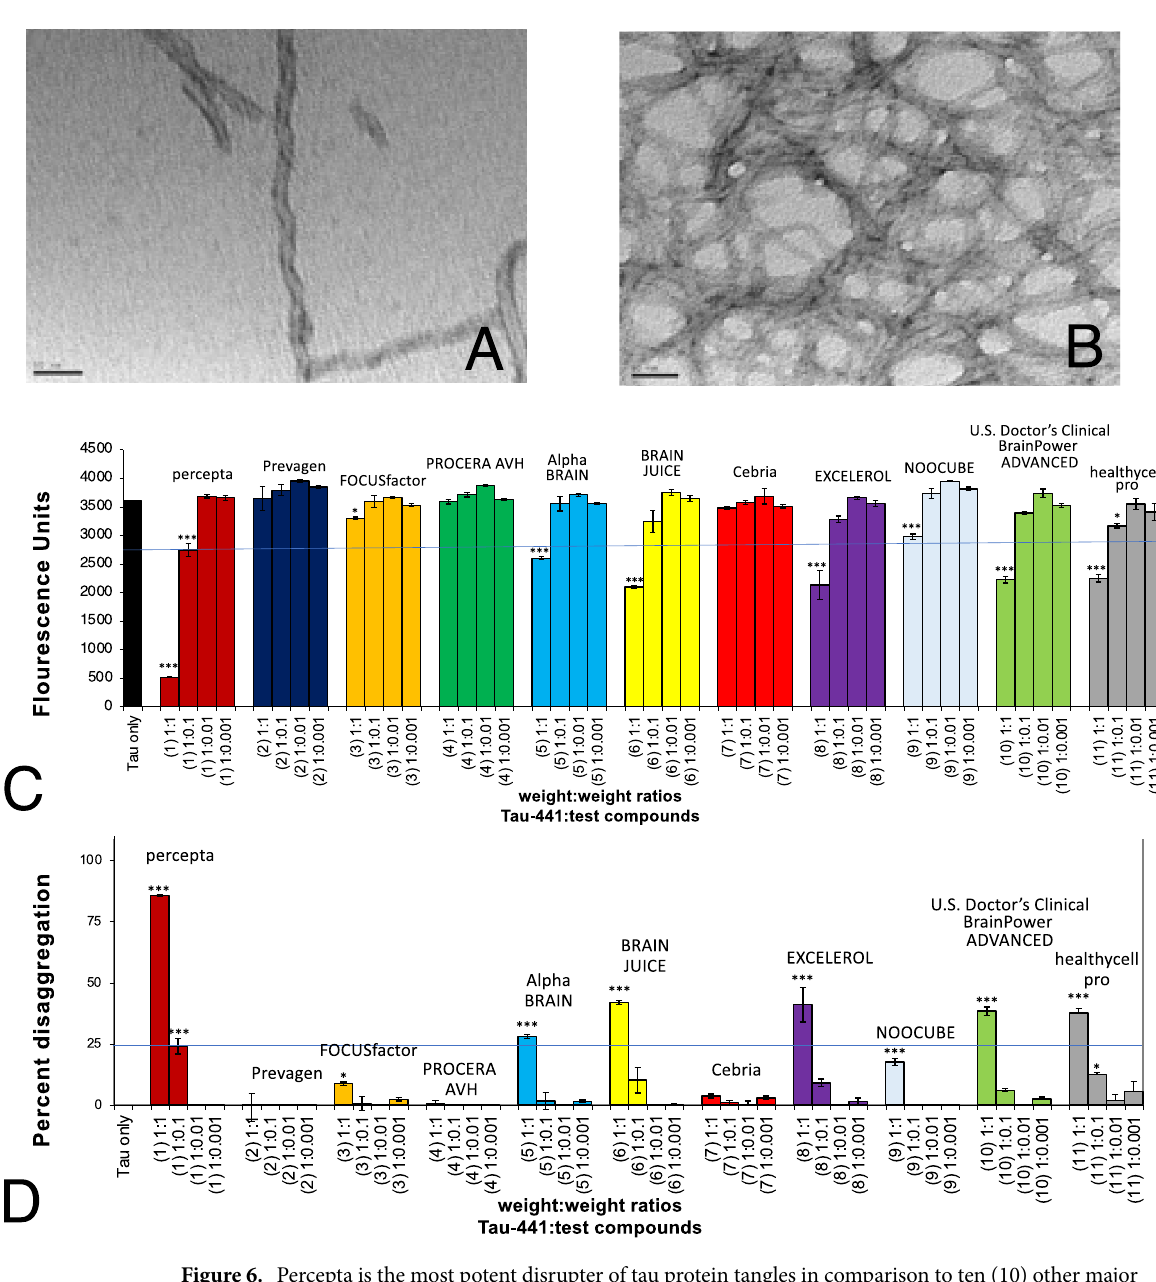
Figure 6. Percepta is the most potent disrupter of tau protein tangles in comparison to ten (10) other major brain supplements on a wt/wt basis. ( A ) Tau-441 induced by heparin forms paired helical filaments as shown by electron microscopy. Scale bar = 50 nm. ( B ) Formation of massive aggregated tau protein paired helical filaments following induction with heparin and shown by electron microscopy. Scale bar = 50 nm. ( C ) Percepta was the most potent disrupter /disaggregator of pre-formed tau protein tangles than any other memory- support supplement tested as shown quantitatively by Thioflavin T fluorometry. Tau protein-441 induced by heparin forms paired helical filaments instantly and shows 3600 Thioflavin T fluorescent units (FU)(black bar). Increasing doses of percepta (tau:percepta wt/wt ratios of 1:0.001, 1:0.01; 1:0.1; and 1:1) demonstrated a marked dose-dependent disaggregation/disruption of pre-formed tau tangles. *p < 0.05, **p < 0.01, ***p < 0.001, by Student’s t-test. Bars represent mean ± SEM. ( D ) Comparison of percepta to 10 (ten) other major memory- support dietary supplements in % disaggregation of preformed Aβ 1–42 fibrils. Percepta had the most robust activity and reduced/disaggregated tau tangles in a dose-dependent manner (light brown bars). Percepta disaggregated tau protein tangles by 86.4% at a tau:percepta wt/wt of 1:1, and by 24.1% at a tau:percepta wt/wt of 1:0.1, and much better than any other major memory-support dietary supplement tested including Prevagen, FOCUSFactor and Alpha Brain. *p < 0.05, **p < 0.01, ***p < 0.001, by Student’s t-test. Bars represent mean ±